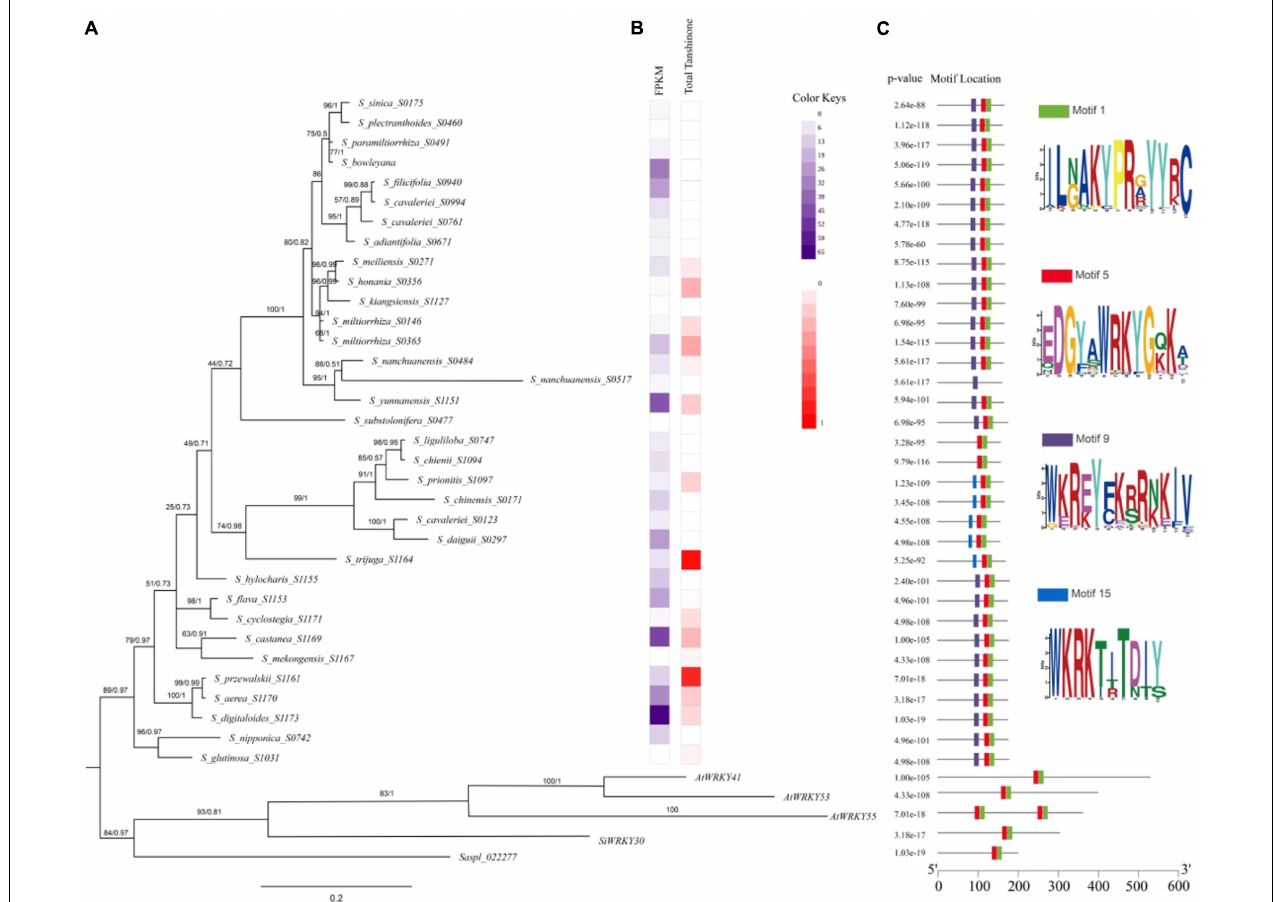
FIGURE 7 | Phylogenetic relationships of conserved protein motifs in WRKY genes in Salvia L. (A) The genetic relationship of the phylogenetic tree constructed by Bayesian Inference (BI) method of WRKY61 homologs in Salvia L. (Clades I–III). Numbers on the branches indicate statistical support values [numbers on left: maximum likelihood bootstrap proportion (ML-BP), numbers on right: Bayesian posterior probabilities (PP)]. (B) Heatmap of HPLC in Salvia L. dihydrotanshinone (DI), cryptotanshinone (CT), tanshinone I (TI), and tanshinone IIA (IIA). (C) The motif composition of S. miltiorrhiza WRKY proteins. The length of protein can be estimated using the scale at the